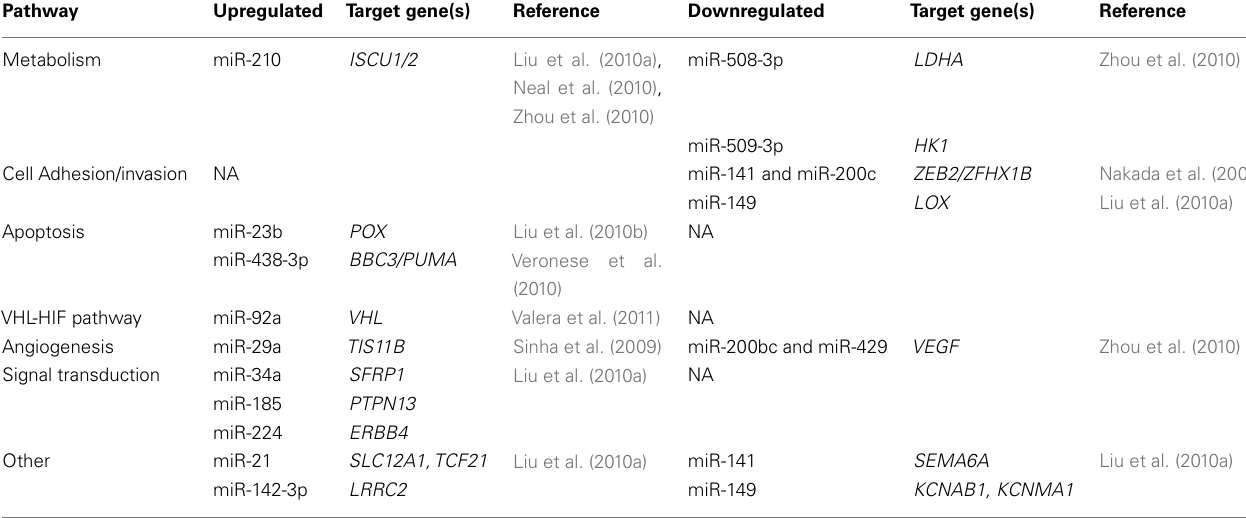
Table 3 | MicroRNA deregulation in renal cell tumors, according to their function/pathway and target genes’.